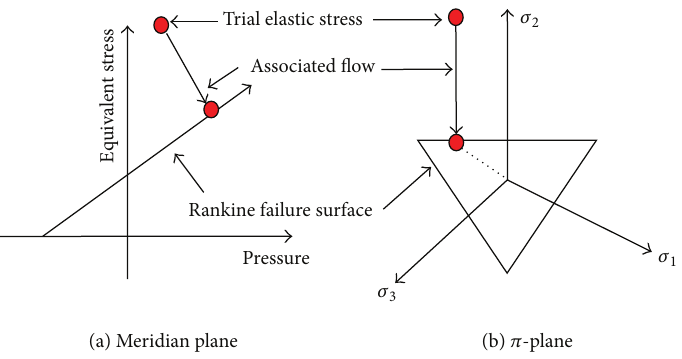
Figure 4: Sketch of associated flow.